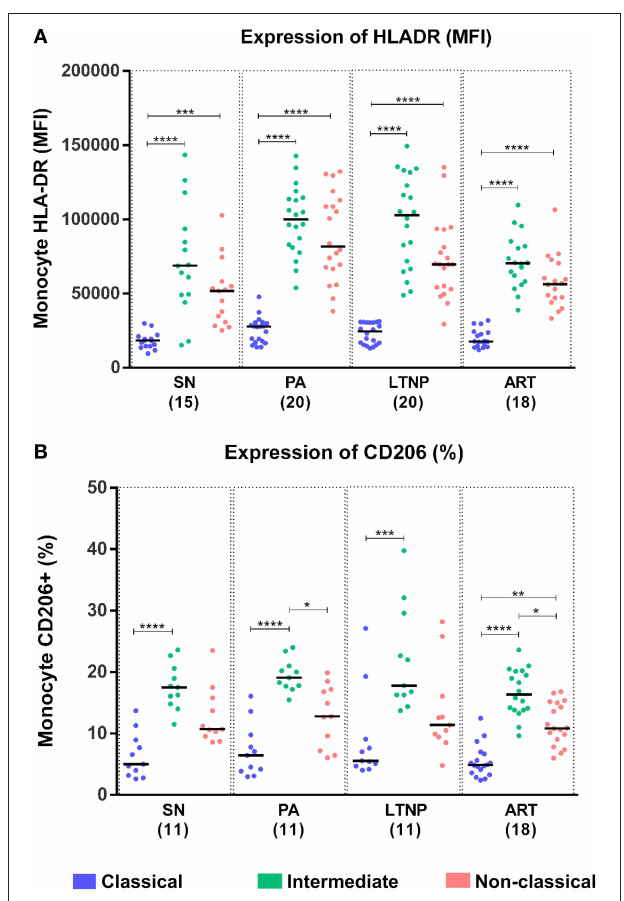
FIGURE 3 | Differential expression of HIV-binding receptors on monocyte subsets. (A) Per-cell expression of HIV-binding receptor CD4 (MFI) was highest on the intermediate monocyte subset across cohorts. Kruskal-Wallis ANOVA followed by Dunn’s multiple comparison test was used to assess significance. Although not significant by ANOVA, per-cell expression of CD4 was observed to be significantly higher on intermediate monocytes in the LTNP group using unpaired t -test ( P < 0.05 for both classical and non-classical subsets). (B) Expression of HIV co-receptor CCR5 (% positivity) was highest on intermediate monocytes across different disease progression states. The plot reflects results of Kruskal-Wallis ANOVA followed by Dunn’s multiple comparison test to assess significance; * P < 0.05; ** P < 0.01.